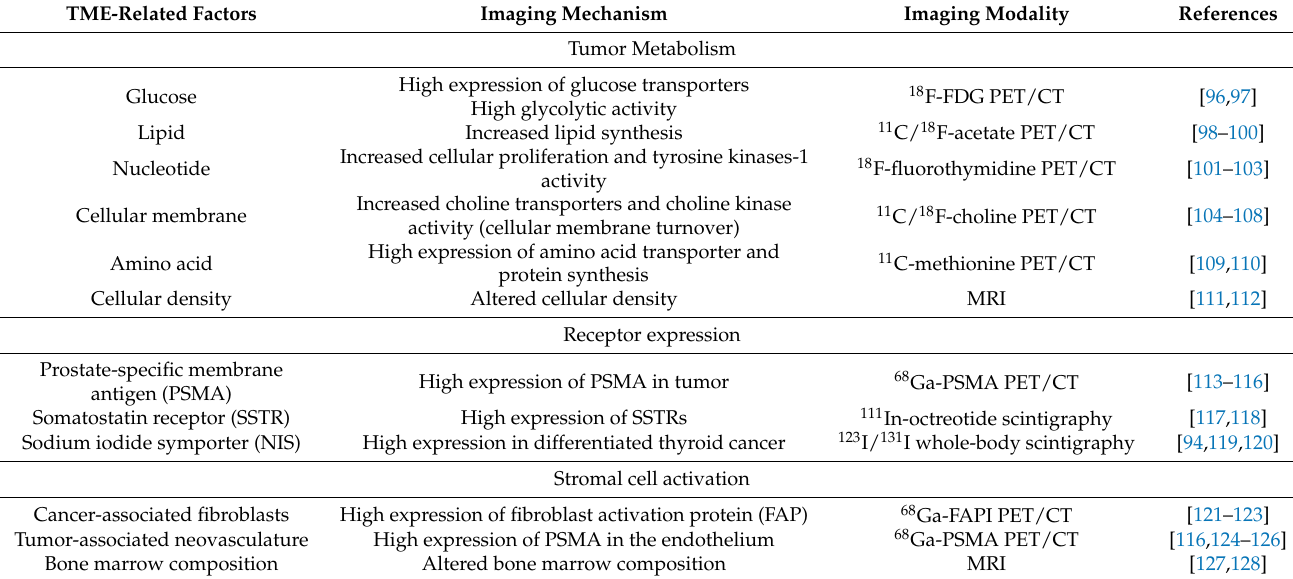
Table 2. Imaging modalities based on tumor microenvironment related factors.